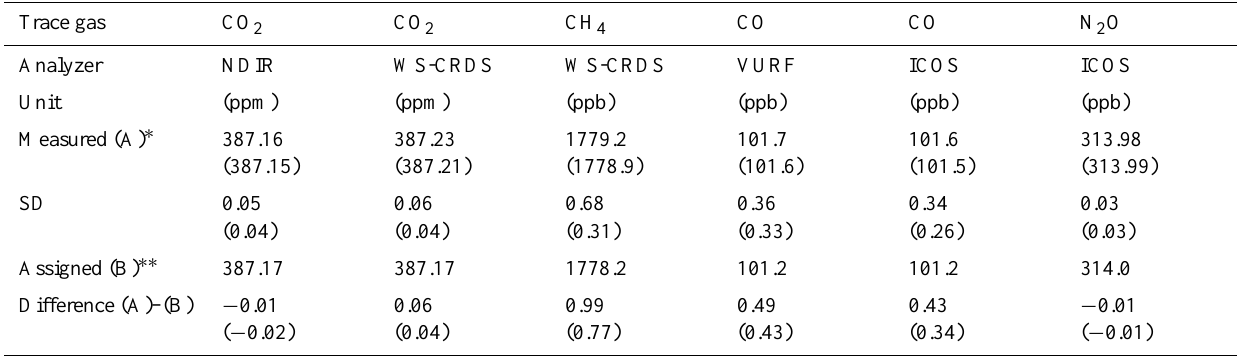
Table 1. Results of repetitive measurements for CO 2 , CH 4 , CO and N 2 O in a multicomponent standard gas filled into 6